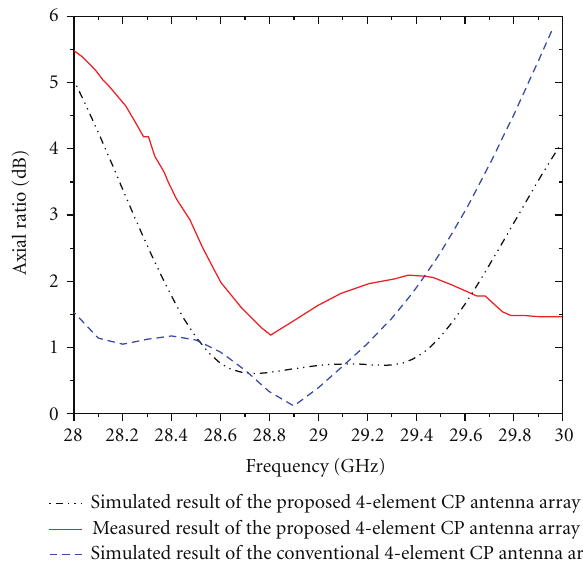
Figure 8: Measured and simulated axial ratio of the 4-element CP antenna arrays.